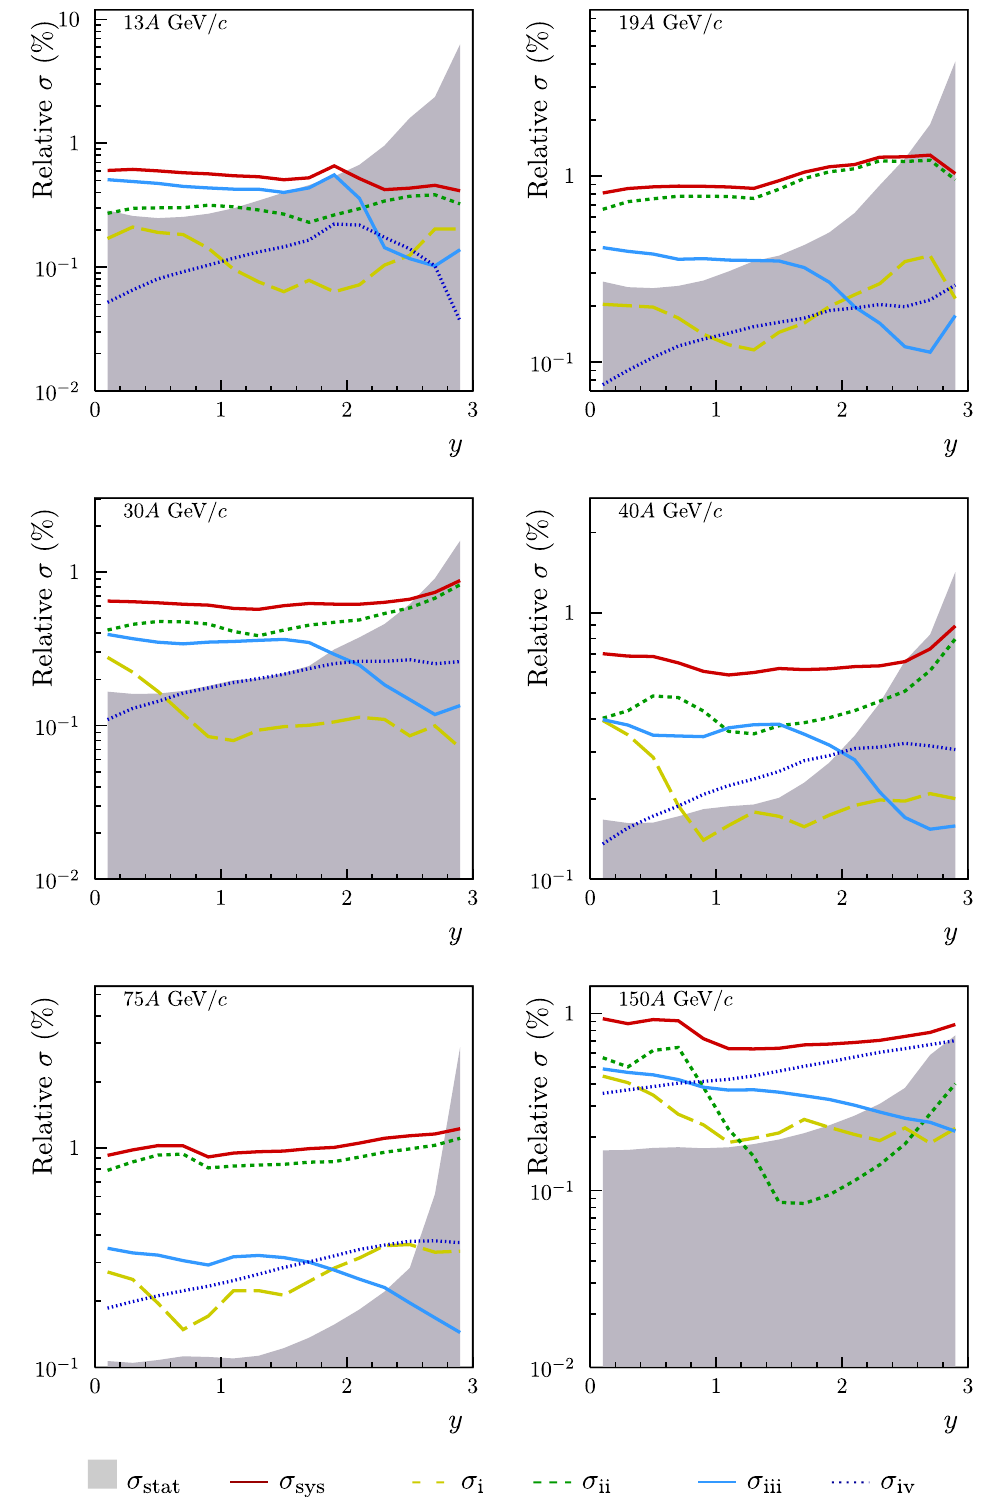
Fig. 8 Statistical and systematic uncertainties for all six beam momenta as a function of rapidity y . Statistical uncertainties are shown bygrayshadedarea,systematicuncertaintiesbycurvesreferringtoelec-